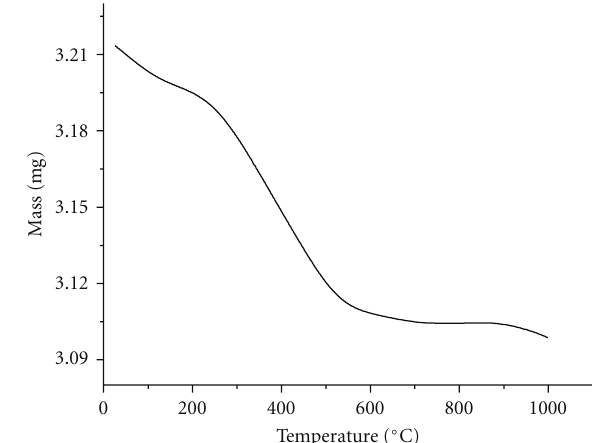
Figure 9: Thermogravimetric profile of the sediment collected at sampling point 5 (March of 2007).